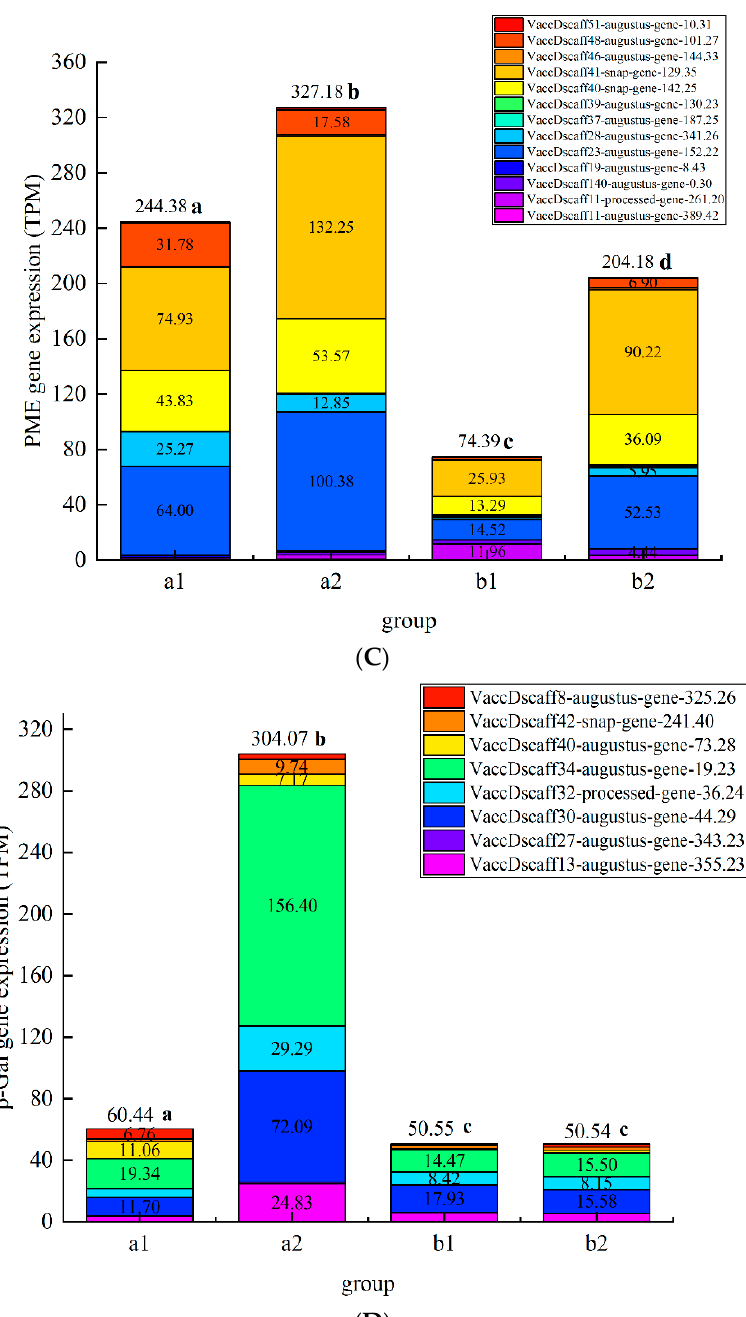
Figure 8. Plot map of gene expression a Plot map of PG gene expression, b Plot map of Cx gene expression, c Plot map of PME gene expression, d Plot map of β -Gal gene expression). ( A ): Plot map of polygalacturonase gene expression. ( B ): Plot map of cellulase gene expression. ( C ): Plot map of pectin methylesterase gene expression; ( D ): Map of β -galactosidase gene expression.